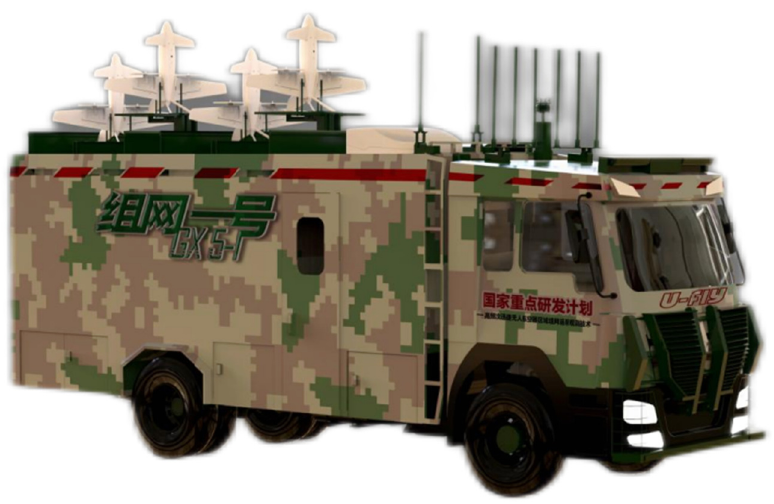
Figure 4. UAV swarm under a centralized networking architecture.